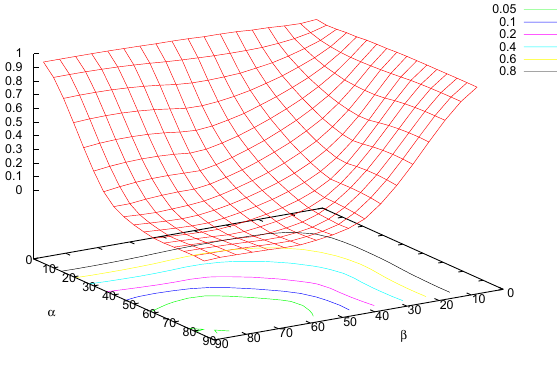
Figure 6. Spectral radius ρ ( M 4 h h ) for a V(0,2) and zebra-smoother for different triangles in function of two of their